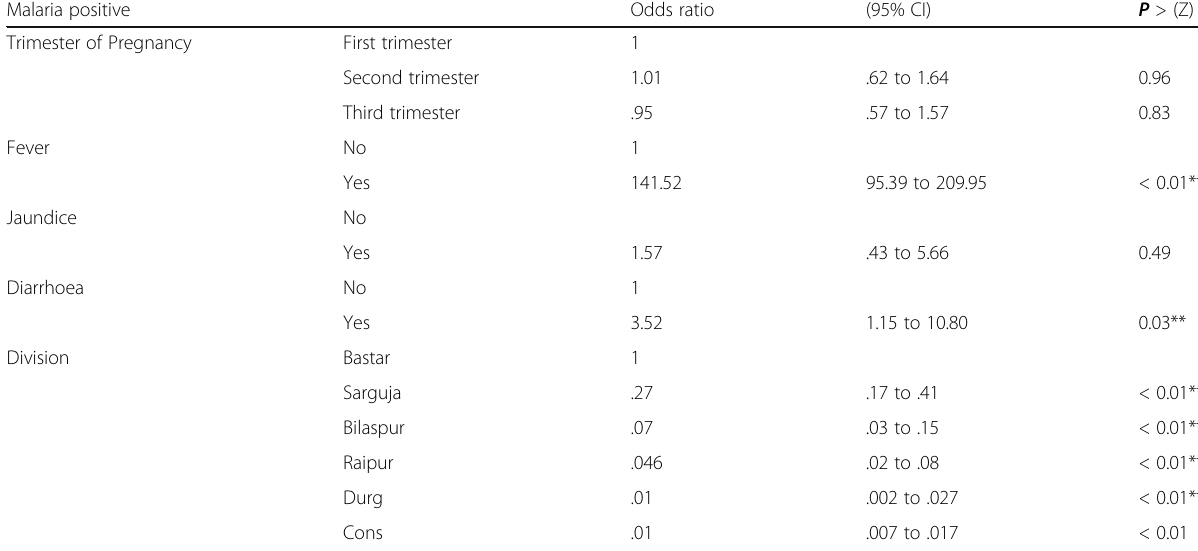
Table 1 The association between geography, symptoms, trimester and malaria positivity Malaria positive Odds ratio (95% CI) Trimester of